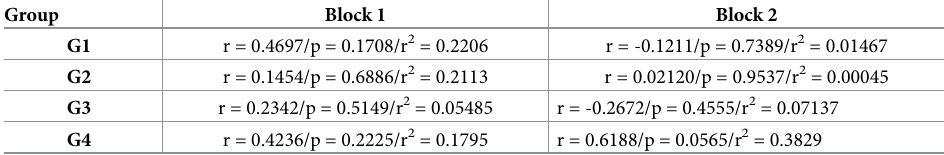
Table 3. Pearson correlation analysis with Pearson- r , p -value, and r -square between insertion torque and initial stability quotient of all groups in both synthetic bone blocks. Group Block 1